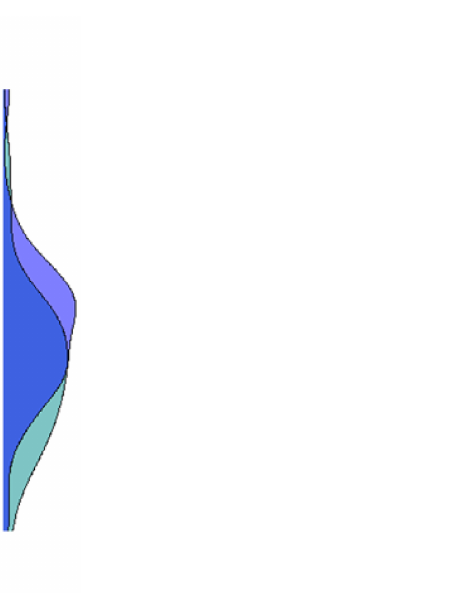
Figure 6. Box plot analysis and marginal distributions of HGF levels in cirrhotic patients and cirrhotic patients with HCC, before the treatments. Patients’ age is visualized using a continuous color